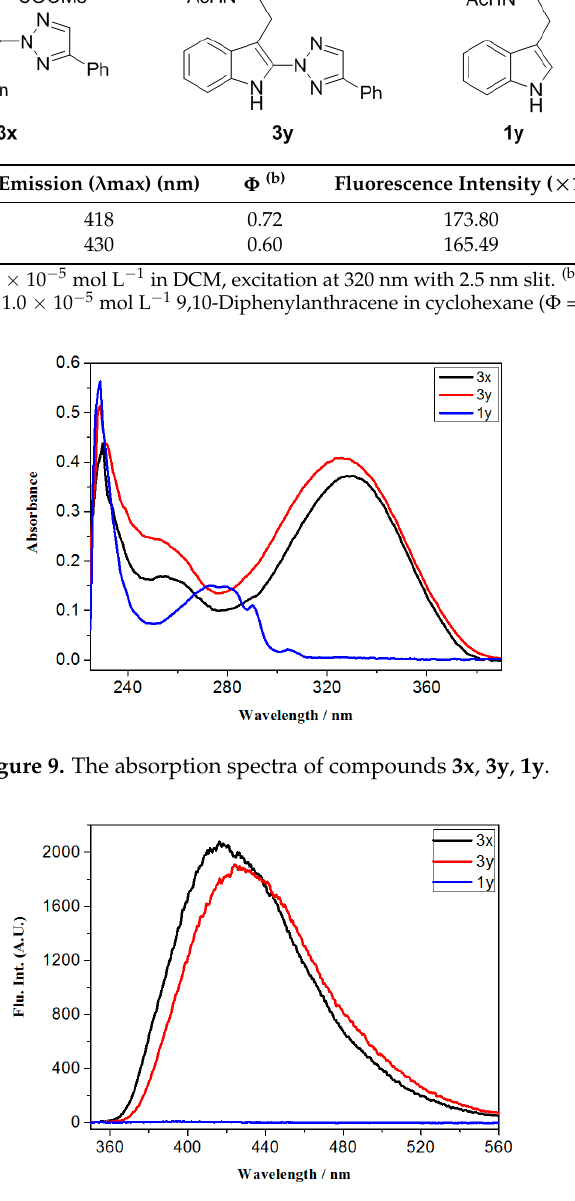
Figure 10. The emission spectra of compounds 3x , 3y , 1y .